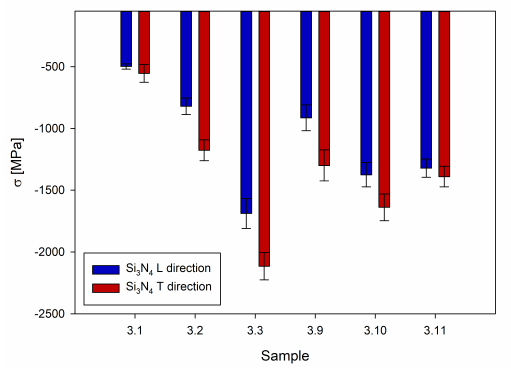
Figure 2. Values of macroscopic residual stresses after grinding by diamond disc (samples x.1-x.3) and AAT (samples x.9-x.11) of Si